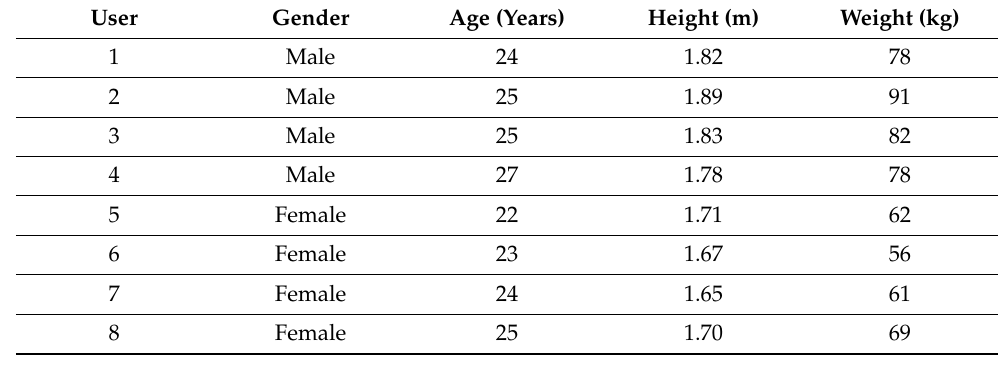
Table 2. Summarizing table reporting on the characteristics of users that tested and characterized the chest band.